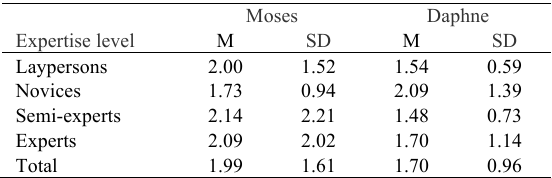
Table 3. Mean values and standard deviations of the